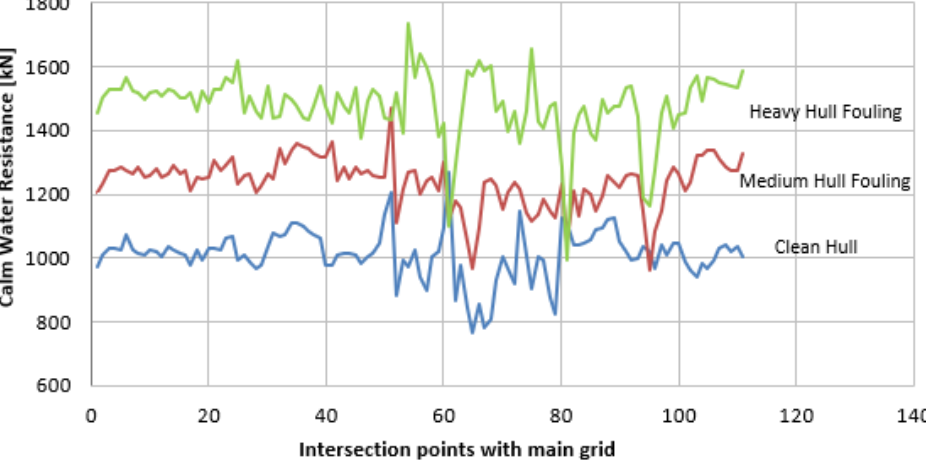
Figure 9. Calm water resistance corresponding to optimum paths for different hull fouling conditions.